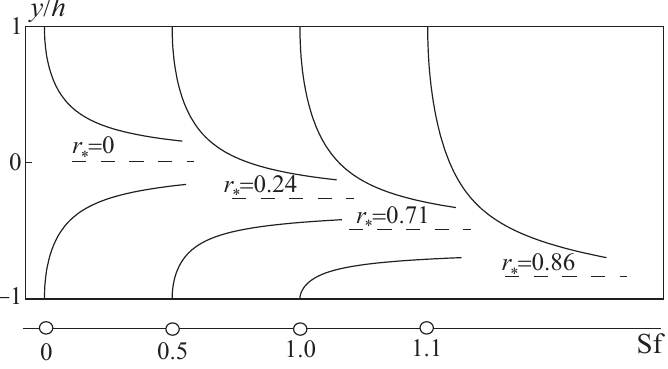
Figure 7. Change in the structure of two-phase flow in a channel with increasing Froude